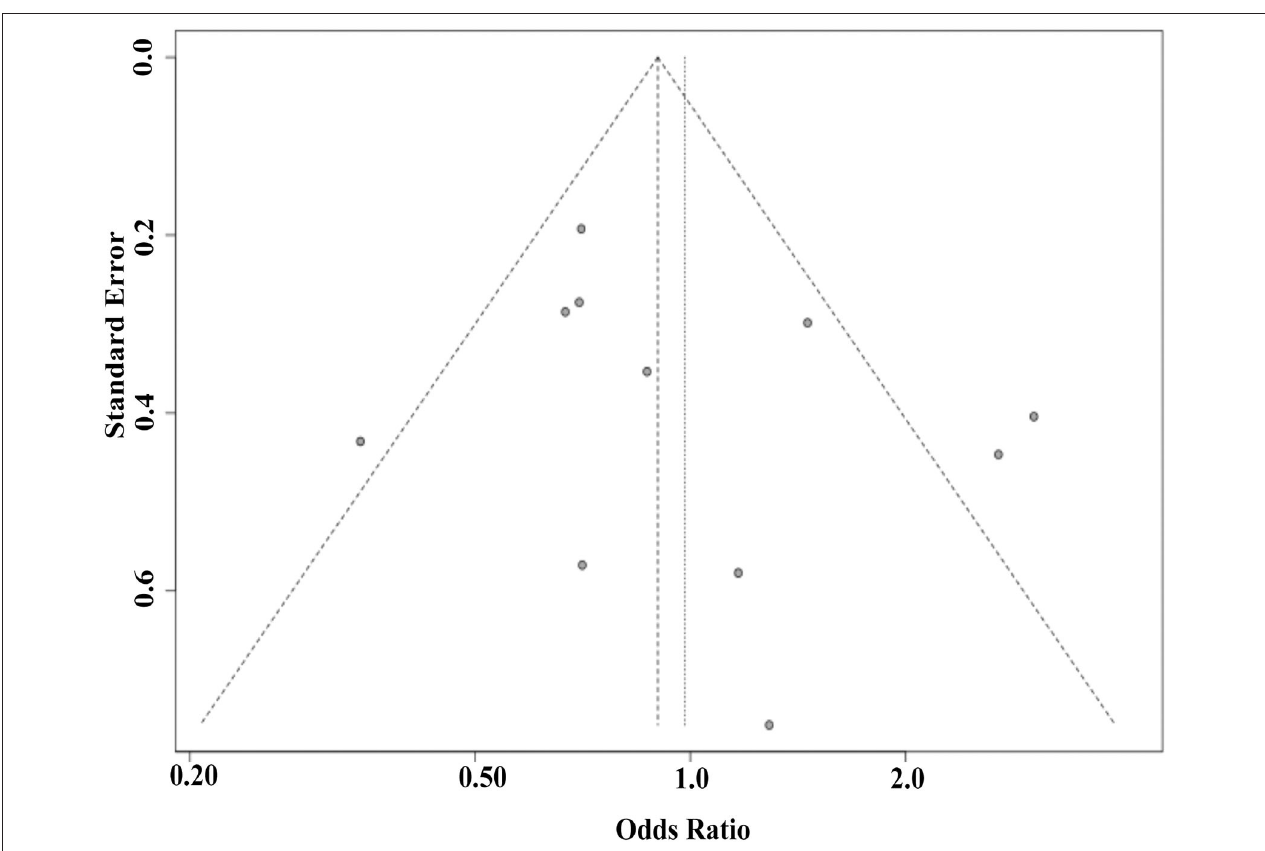
FIGURE 4 | Begg’s funnel plot estimating the publication